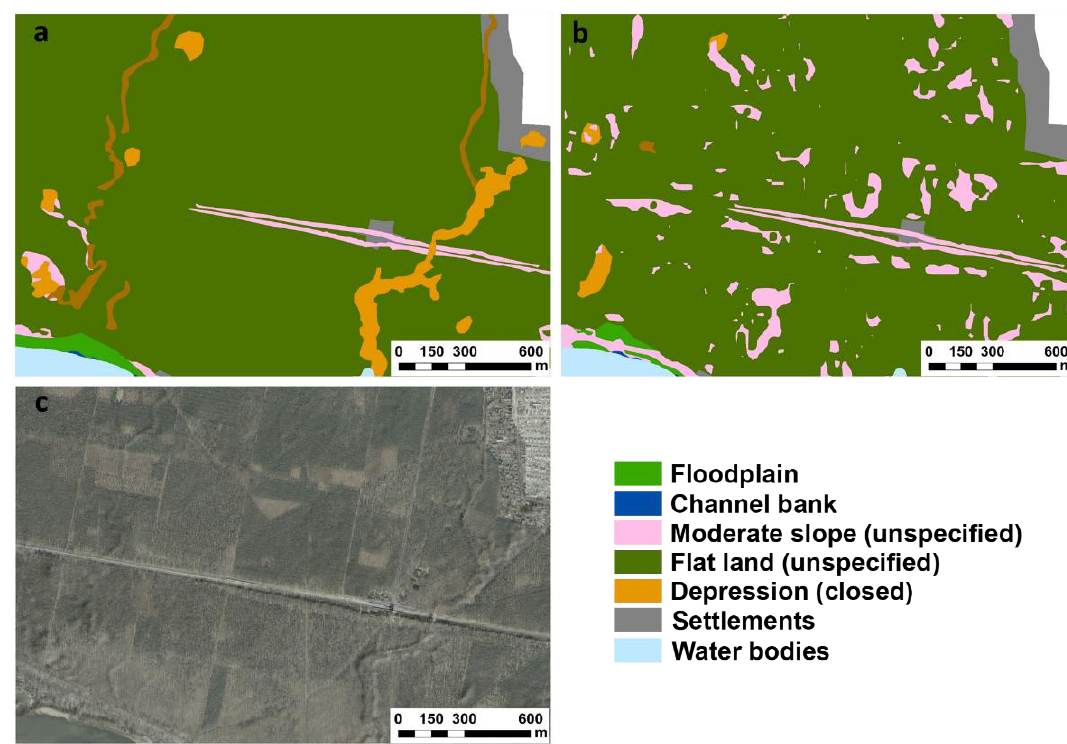
Figure 11. Open and closed Depression: Landform classification based on LiDAR-DEM ( a ), landform classification based on ASTER-DEM ( b ) and orthophoto (0.2 m) ( c ).